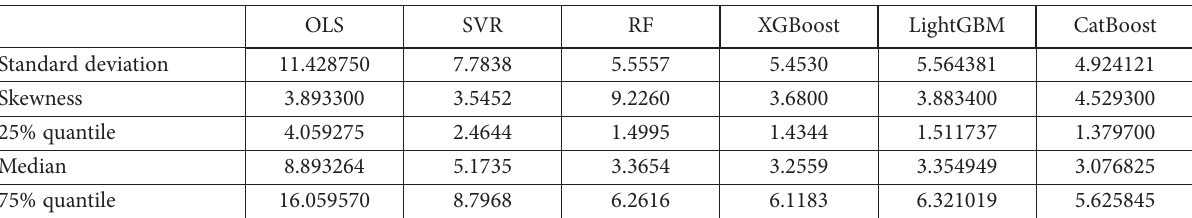
Table 10. Statistics for absolute percentage error: single-algorithm predictors